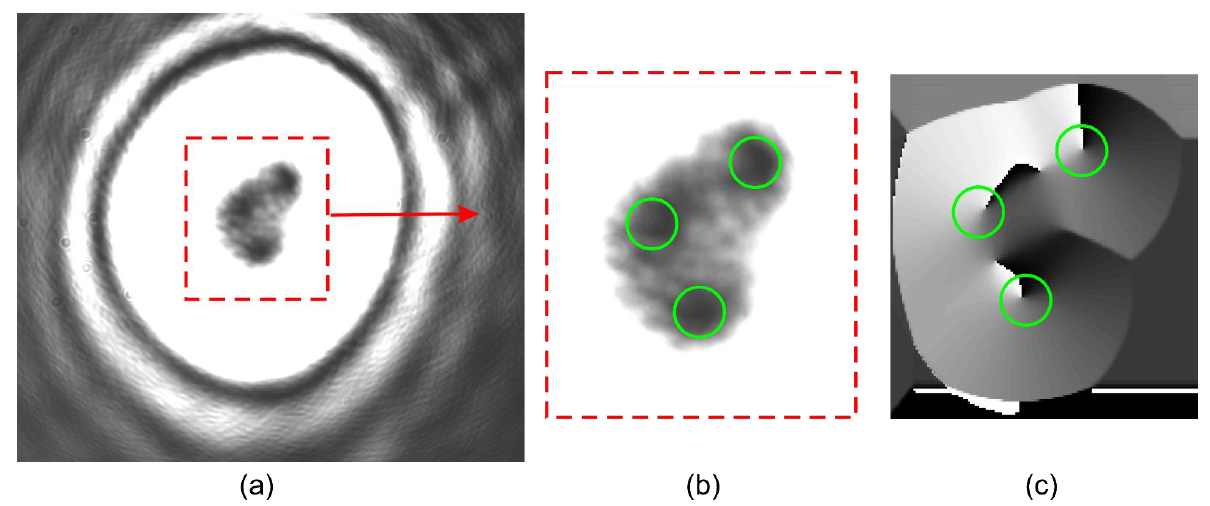
Figure 11. Experimental results with a separated optical vortex with the topological charge of m = 3. Measurements made without an additional beam (Figure 8). ( a ) Intensity, ( b ) magnified intensity area, ( c ) pseudo-phase profile. The green circles represent the locations of the vortex points.